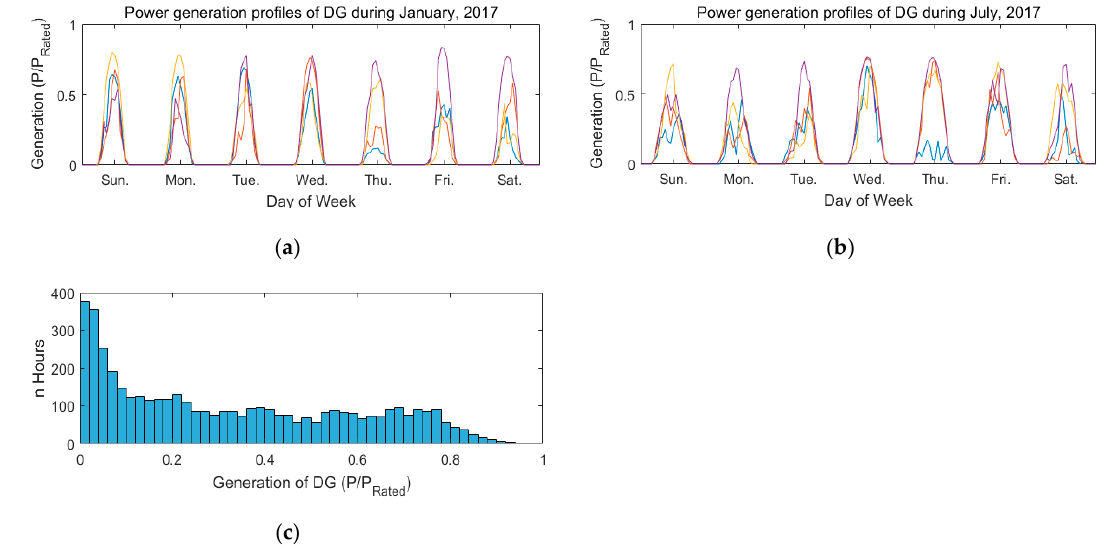
Figure 10. Setting of reactive power control methods applied to test feeder model; ( a ) PF-P characteristic curve for PF(P) method; ( b ) Q-V characteristic curve for Q(V); ( c ) K-P characteristic curve for proposed method.